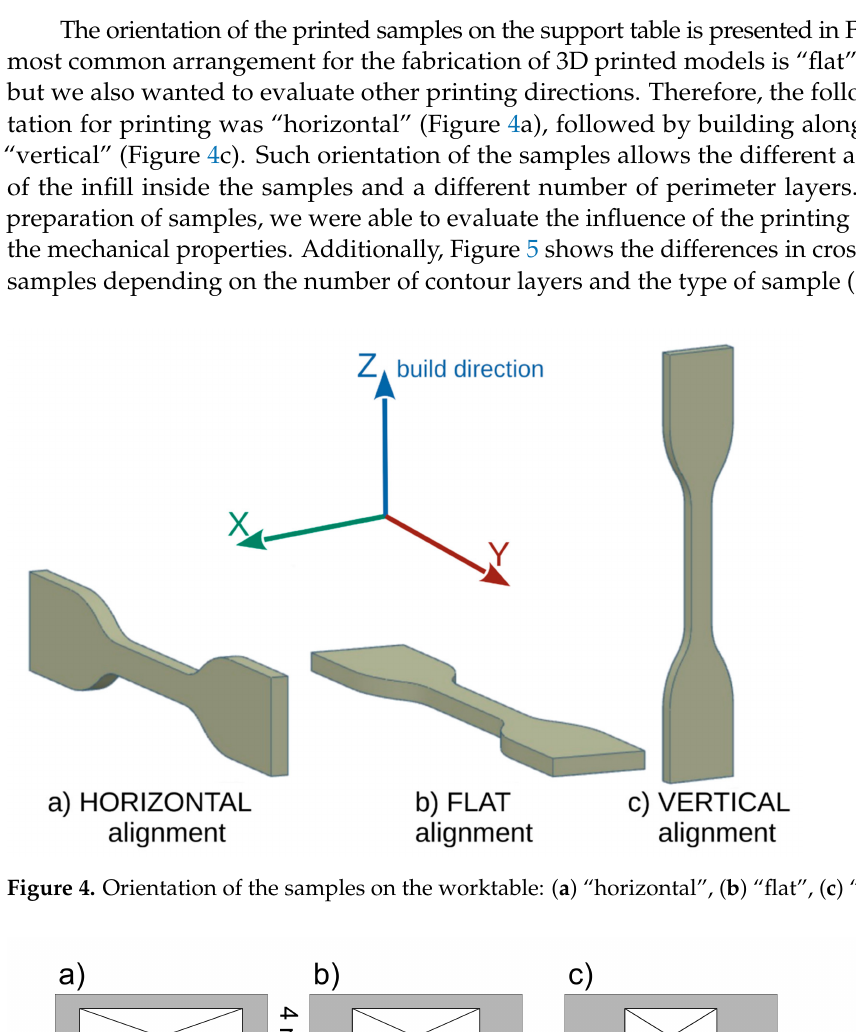
Figure 3. Photographs of printed samples showing the difference in the number of contour layers: ( a ) 3, ( b ) 5, ( c ) 7, ( d ) 9, ( e ) 11, with the same value of infill, 50%.